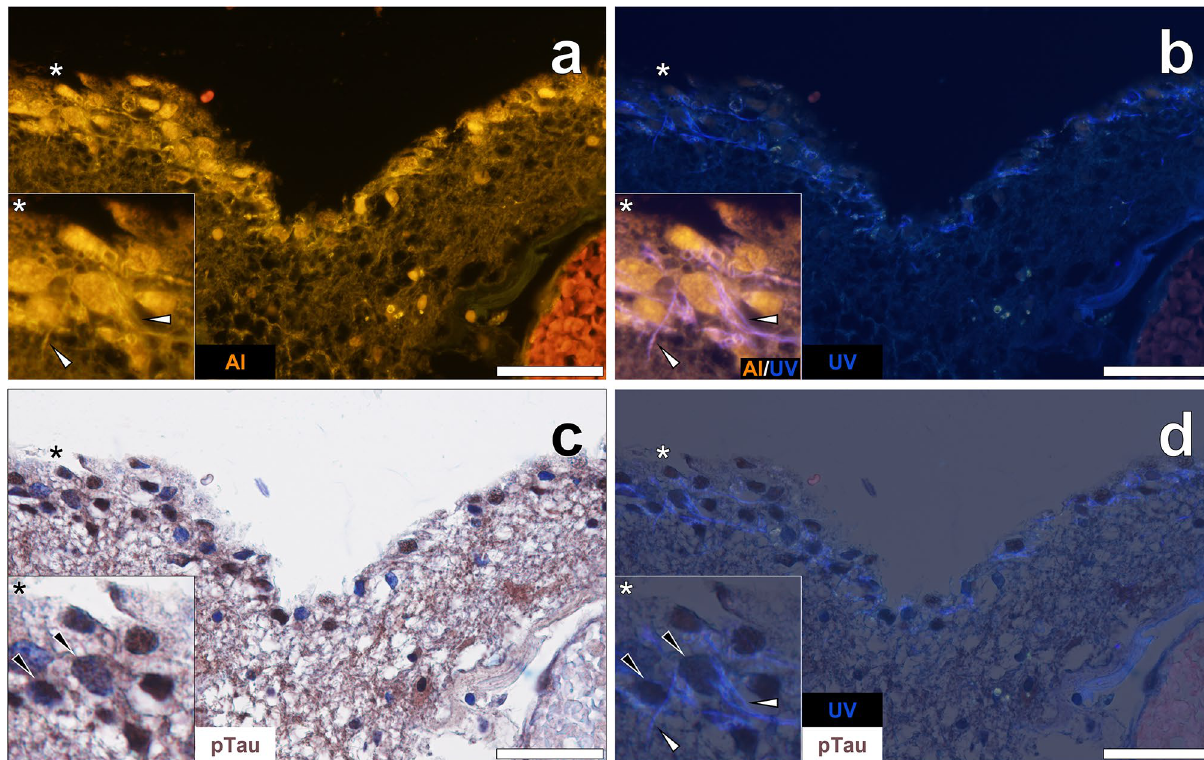
with positive staining (orange) also noted in Biondi tangle-like cellular processes (white arrows). ( b ) Protein autofluorescence of Biondi ring tangles observed under UV illumination (merged with the lumogallion fluorescence channel in the insert). ( c ) Brown intracellular phosphorylated tau (pTau) DAB immunostaining (black arrows). ( d ) Merging of the brightfield channel with UV induced autofluorescence